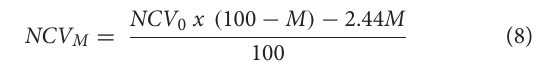
TABLE 3 | Summary of woody biomass physical properties before NAD (sample size of 3 for averaged data). Hog fuel Sawmill woodchips Bark Bark − 2nd trial MC, n = 3